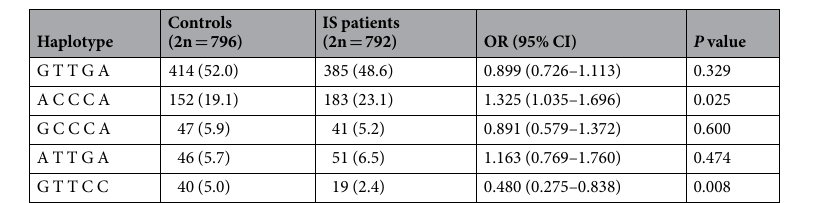
Table 4. Haplotype analysis of the S100B polymorphisms with risk of IS. IS, ischemic stroke; OR, odds ratio; 95% CI, 95% confidence